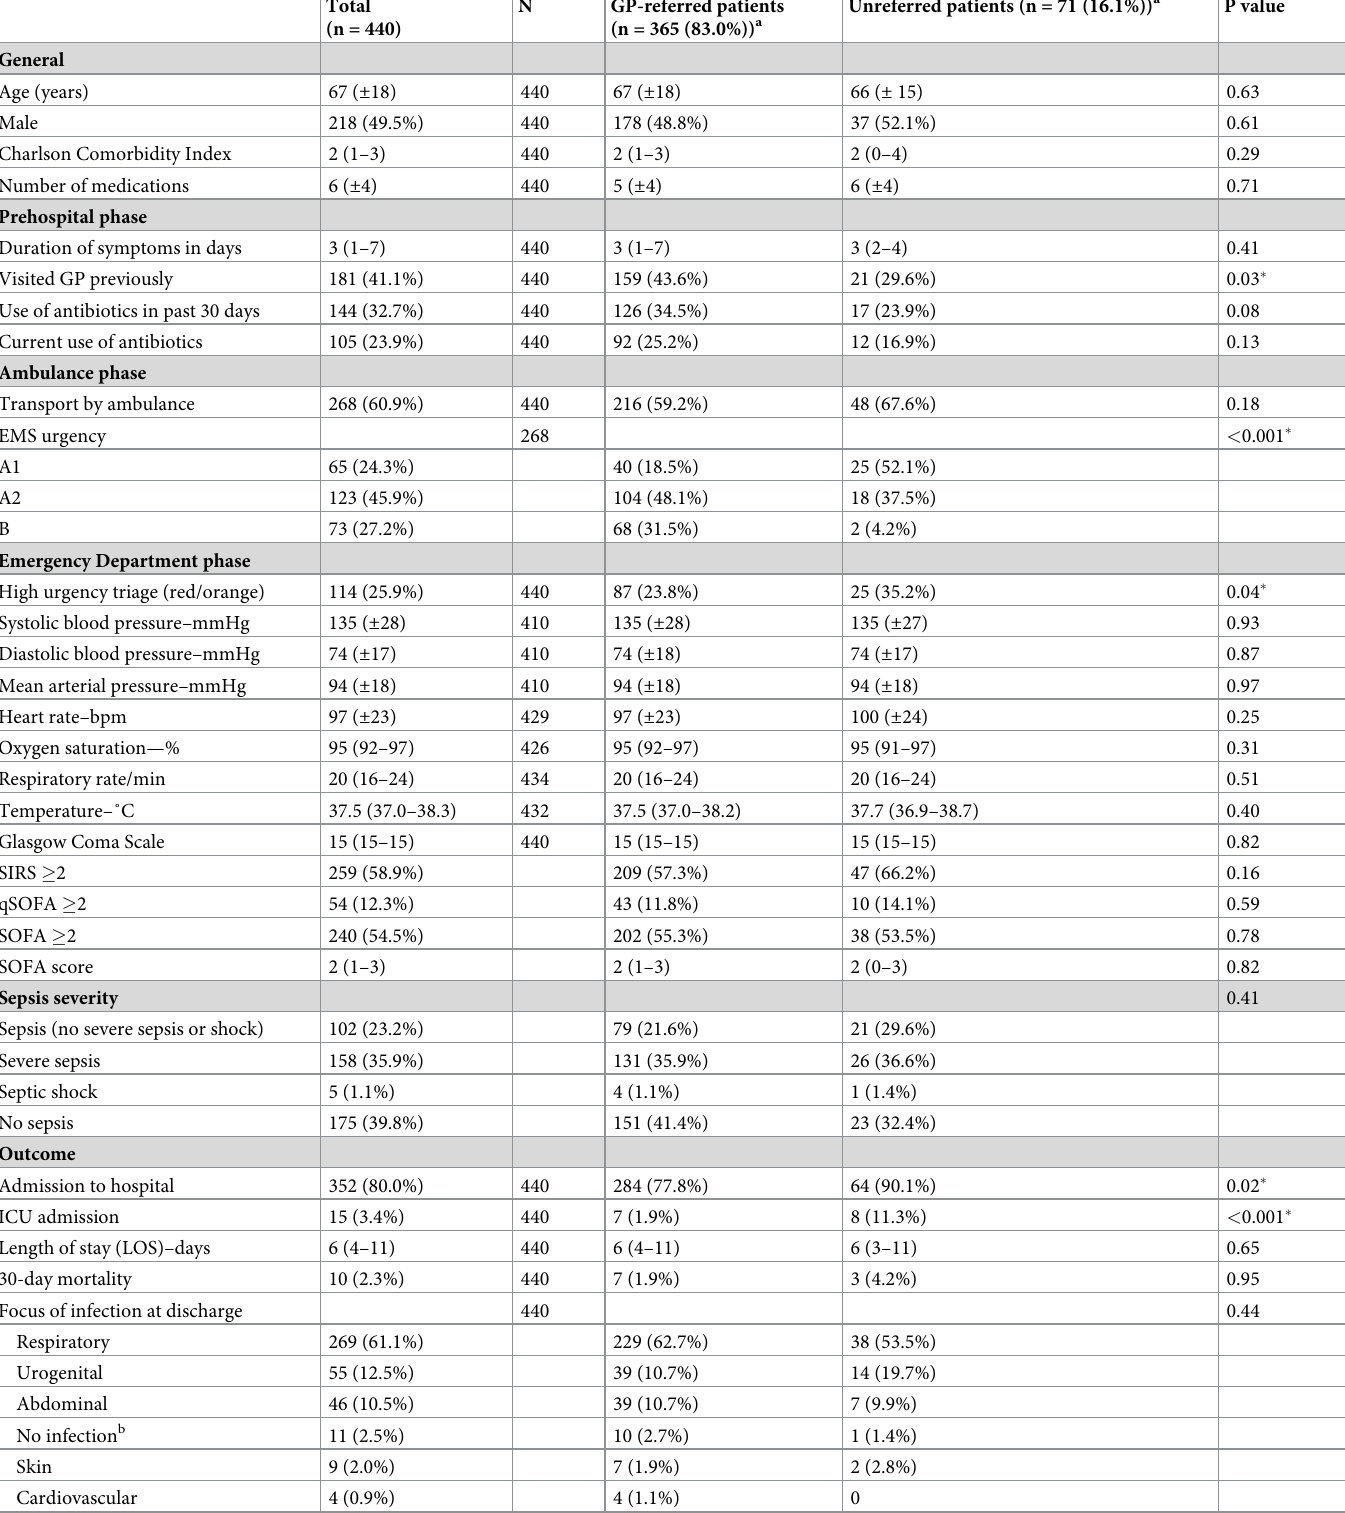
Table 2. Baseline characteristics and outcomes of patients with a suspected/proven infection in the ED and a comparison between GP-referred and unreferred